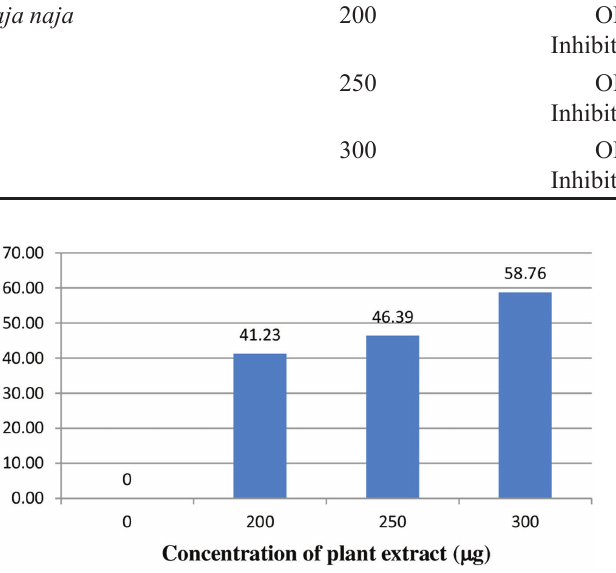
FIGURE 3 - ATPase inhibition assay.